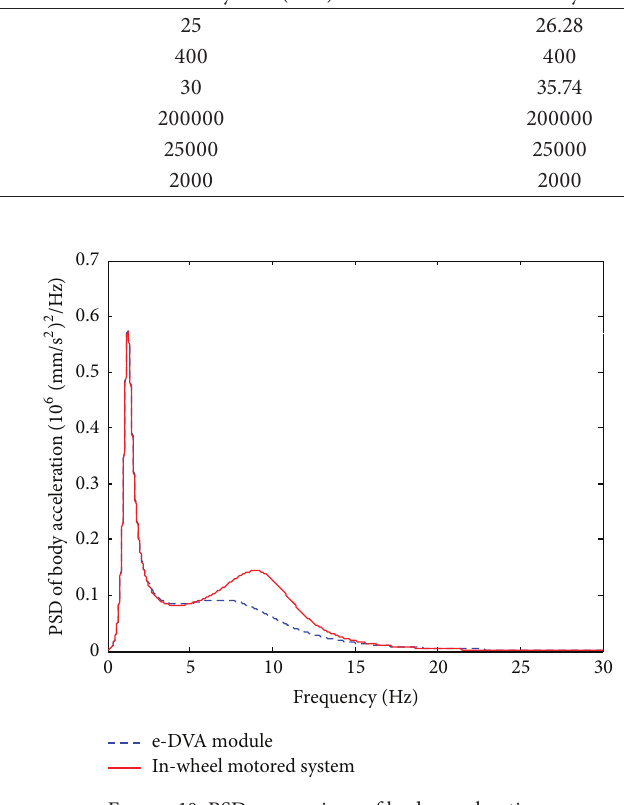
Figure 10: PSD comparison of body